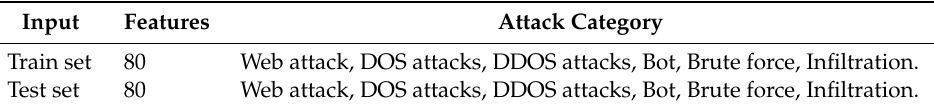
Table 4. Data distribution for misuse attack